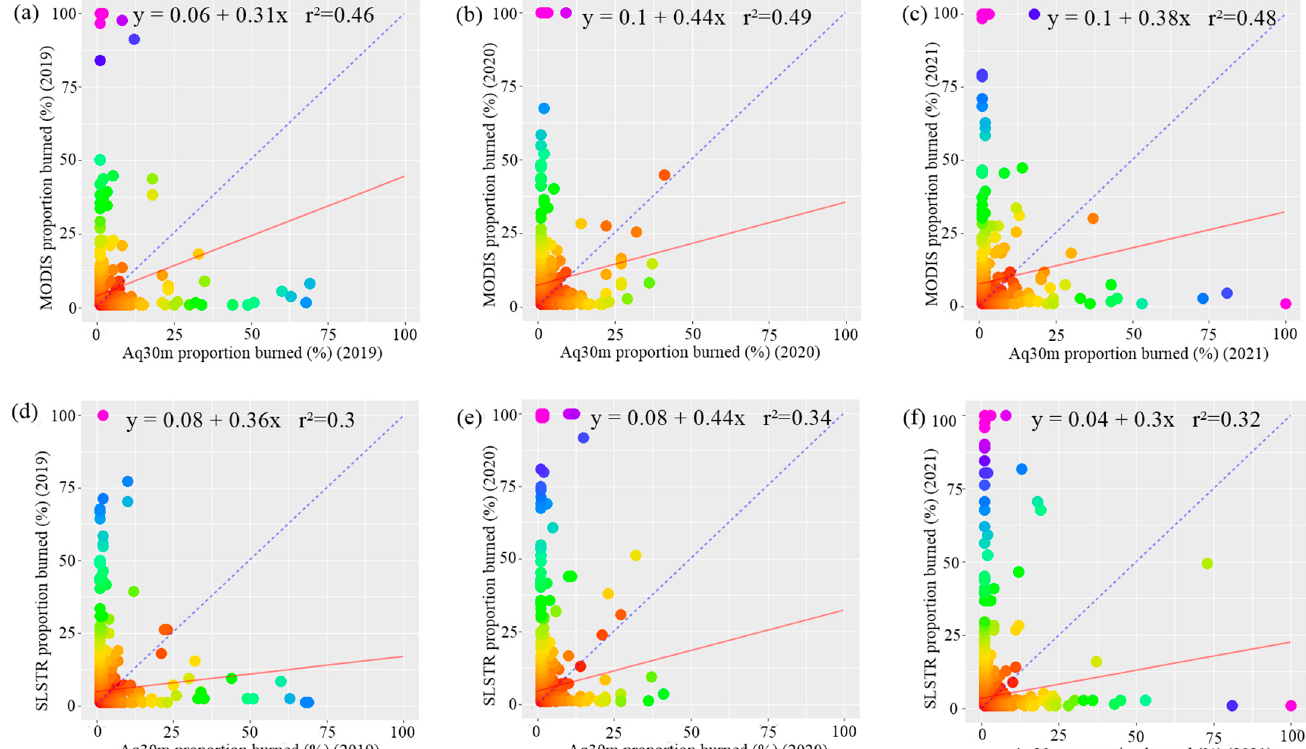
Figure 6. Regressions of the proportion of burned area in each 5 × 5 km square grid of the maps generated by the SLSTR and MODIS sensors and the reference map derived from the Aq30m during the fire season for the years ( a ) and ( d ) 2019, ( b ) and ( e ) 2020, and ( c ) and (f) 2021.